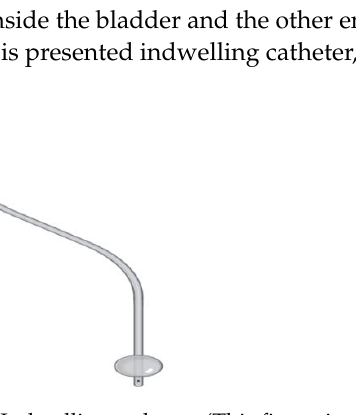
Figure 1. Indwelling catheter. (This figure is created by bio render [11]).